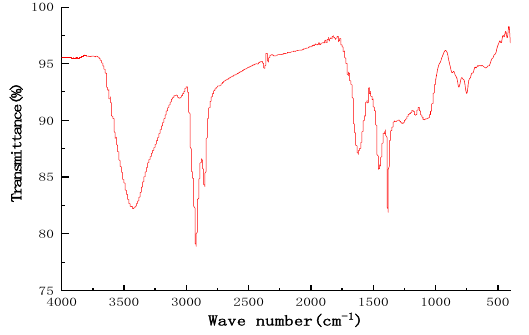
Figure 3. FTIR spectrum of the asphaltene.